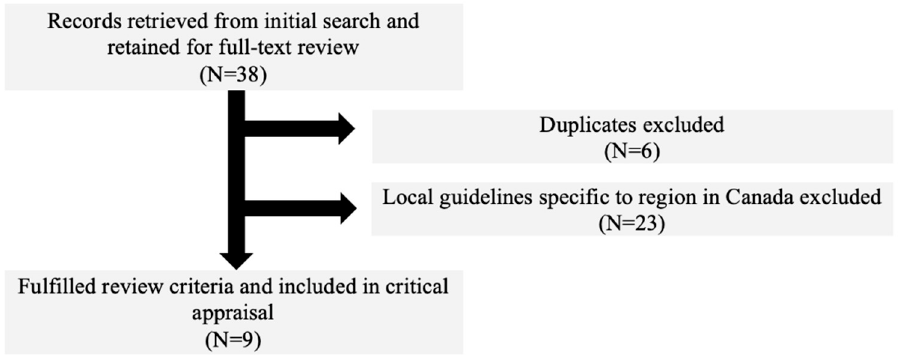
Figure 1. Flow diagram of selection strategy and article reviews.